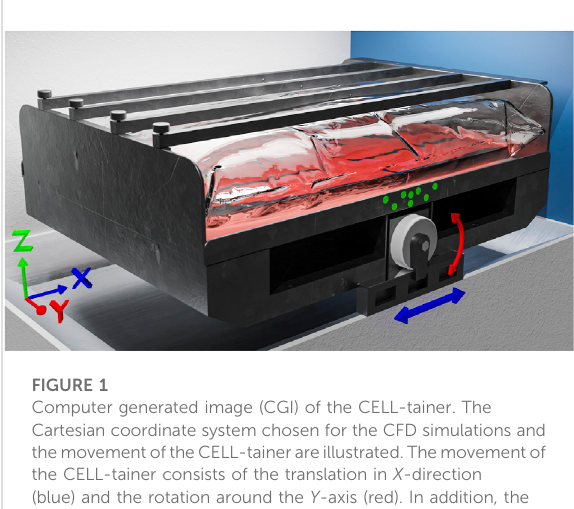
FIGURE 1 Computer generated image (CGI) of the CELL-tainer. The Cartesian coordinate system chosen for the CFD simulations and themovementoftheCELL-tainerareillustrated.Themovementof the CELL-tainer consists of the translation in X -direction (blue) and the rotation around the Y -axis (red). In addition, the marker positions for the motion capturing method described in Section 2.1 are drawn in green. An animated version including a CFD simulation can be found in the Supplementary Video